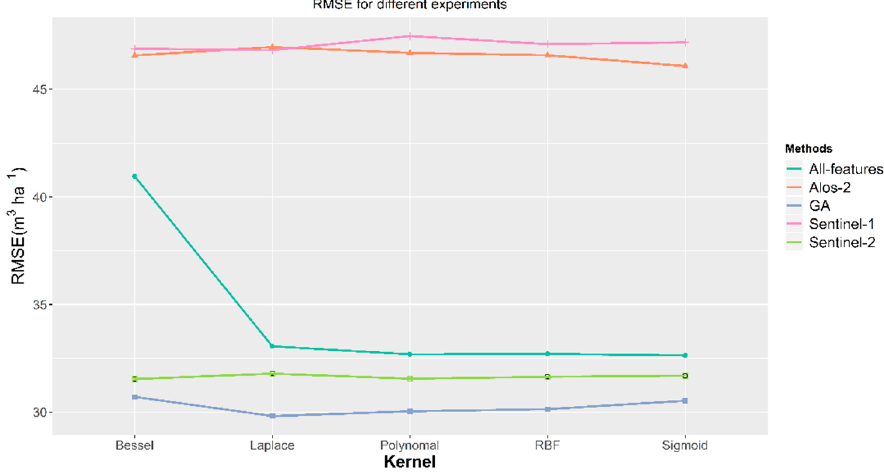
Figure 3. RMSE plot for different experiments.